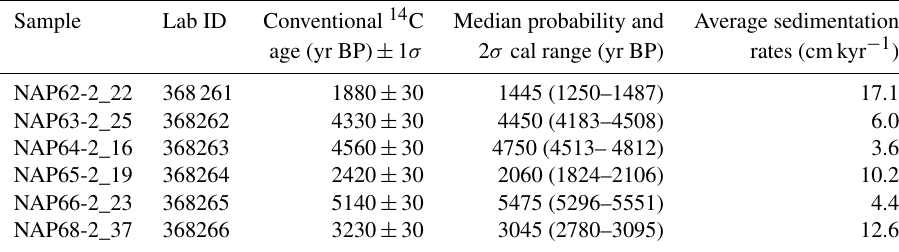
Table 2. AMS radiocarbon datings of the multiple cores. (cid:49)R = 7 ± 200 (Lund et al., 2014). Sample Lab ID Median probability